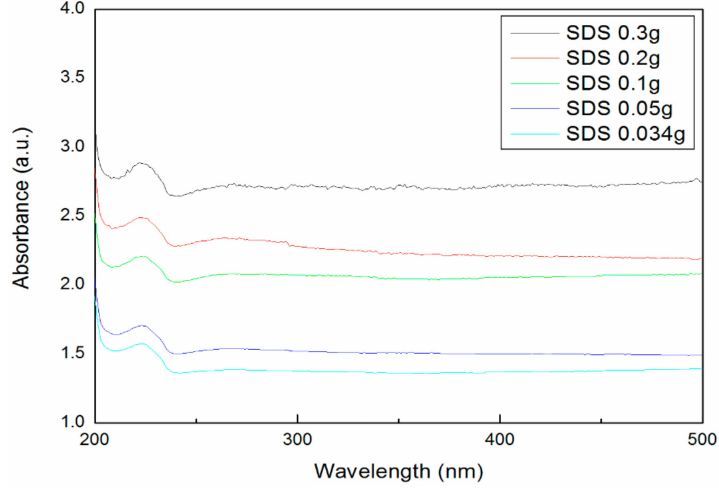
Figure 4. Absorbance of graphene by SDS addition